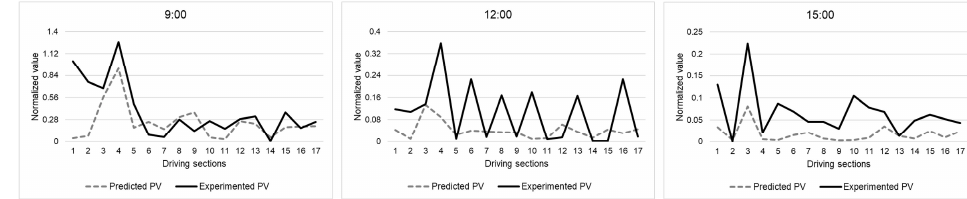
Figure 12. Comparison between normalized PV potentials predicted and observed of module B.